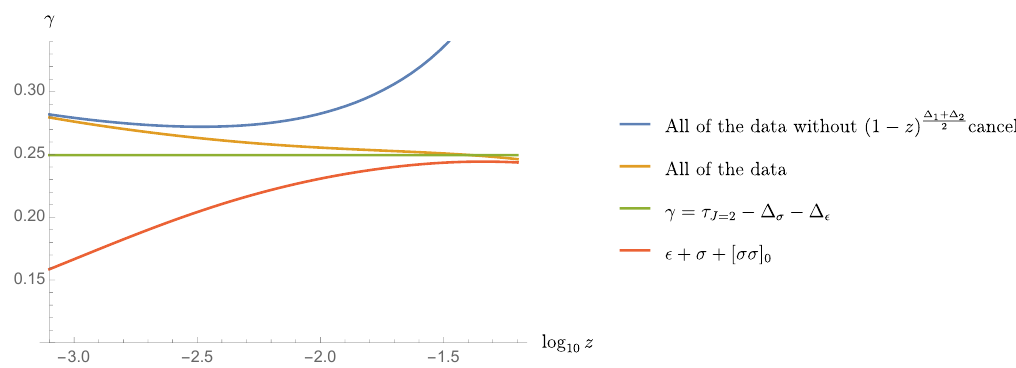
Figure 15 . γ ( β = 6 . 18) is given for comparison between different truncation in the cross-channel expansion of the dDisc. We see the importance of including the subleading families to get a plateau. In addition, multiplying C even ( z, β ) with (1 − z ) ∆1+∆2 2 has been shown to extend the range of z in which we have a flat curve (see the paragraph below figure 3 for explanation).